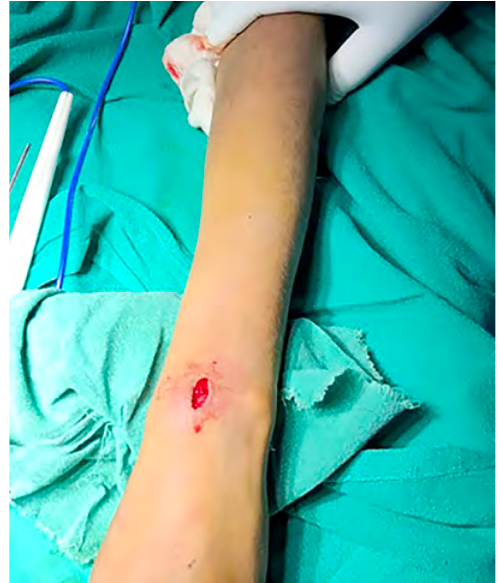
Fig 3 : Incision above wrist, lateral to the radial tuberosity